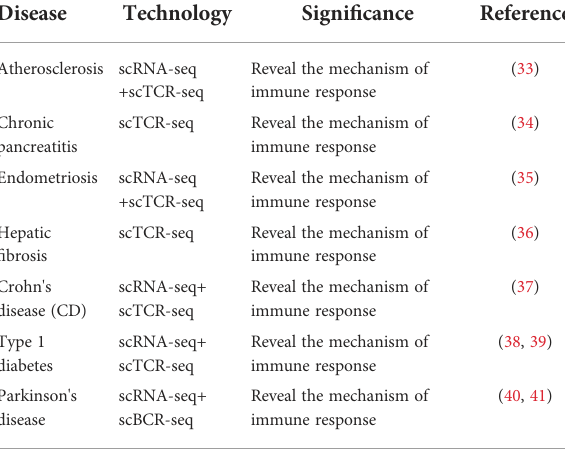
TABLE 4 Summary of studies on the application of single-cell TCR/ BCR sequencing technology in chronic diseases.